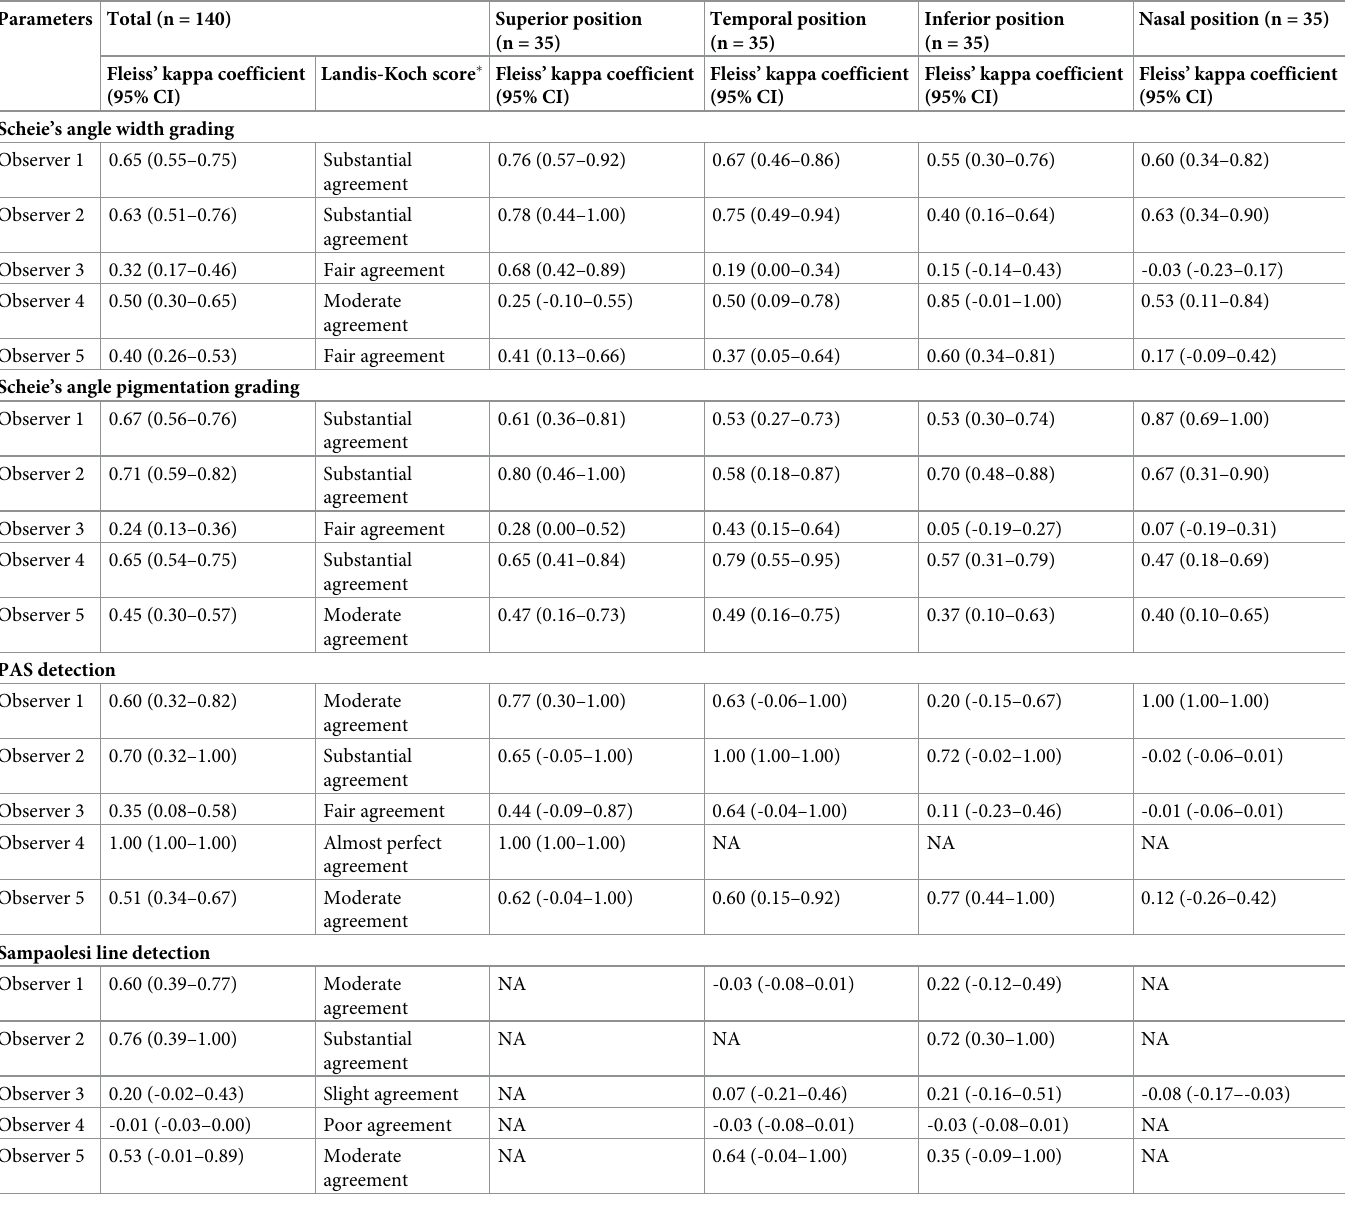
Table 3. Intraobserver agreement analyses for angle evaluations using gonioscopic photos obtained using the GS-1. Parameters Total (n =